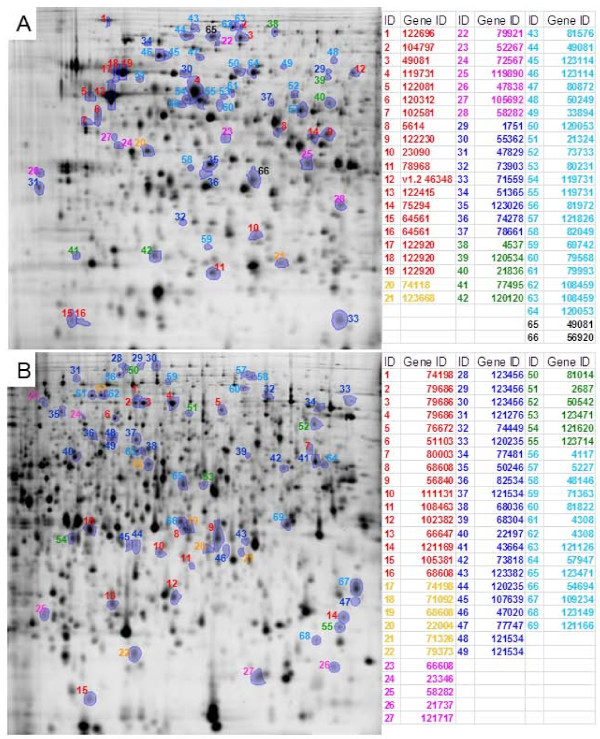
Identified protein spots in 2D analysis. In panel 'A' pH interval 3-5.6 in IEF and in panel 'B' 5.3-6.5 in IEF. Protein spots more abundant in D03 cultivations than in HD cultivations in red. Respectively, in D03 than in D06 and HD in orange; in D03 than in HD in pink; in HD than in D03 in dark blue; in HD and D06 than in D03 in green; in D06 than in D03 in light blue; other comparisons in black.